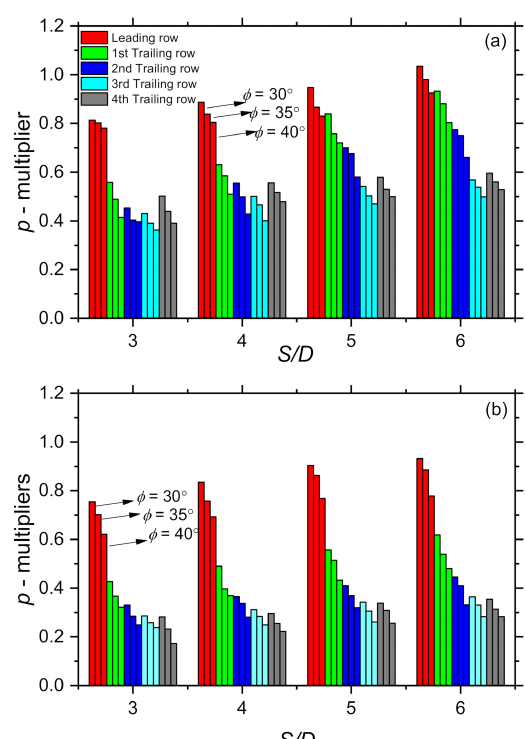
Figure 4. Numerically calculated p -multipliers for 5 × 5 ( a ) free-head and ( b ) fixed-head pile